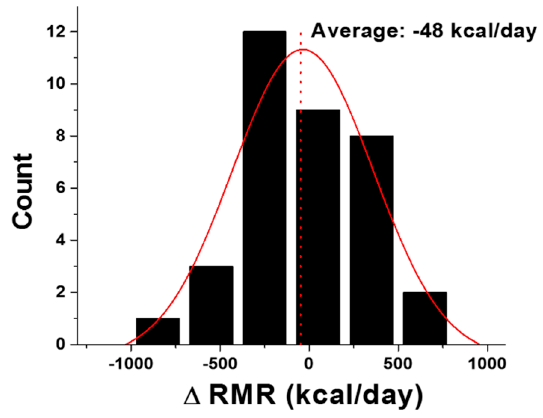
Figure 3. Distribution of RMR difference between the two methods, ∆ RMR = RMR from the MSJE − RMR from the mobile IC.